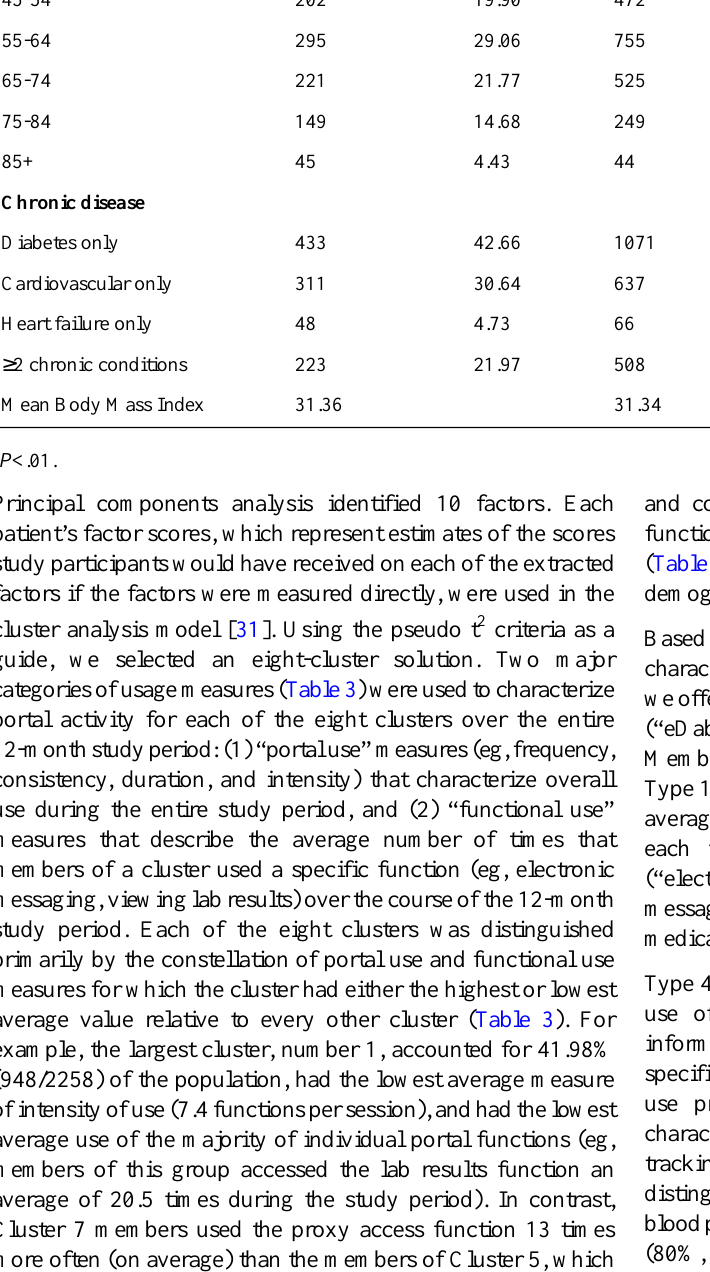
Portal non-registrants